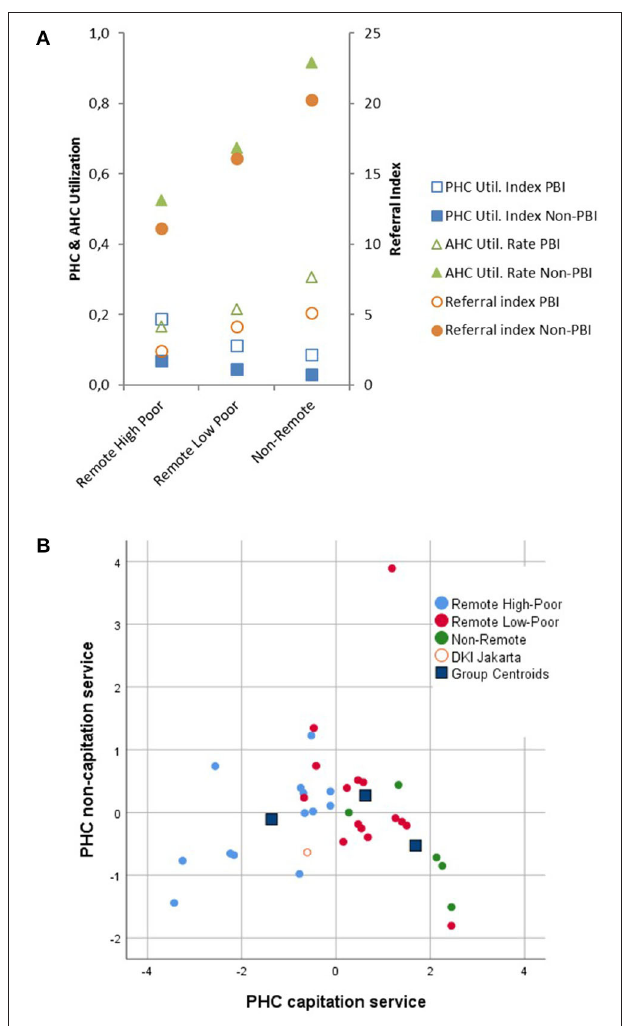
FIGURE 3 | Healthcare services for PBI ( (cid:3) ) and Non-PBI insurance ( (cid:4) ) members. (A) PHC Utilization Index (primary care) ( (cid:4) ), AHC Utilization Rate (advanced care) ( N ) and AHC/PHC Referral Index ( • ). (B) Canonic discrimination functions obtained by capitation and non-capitation PHC primary services.